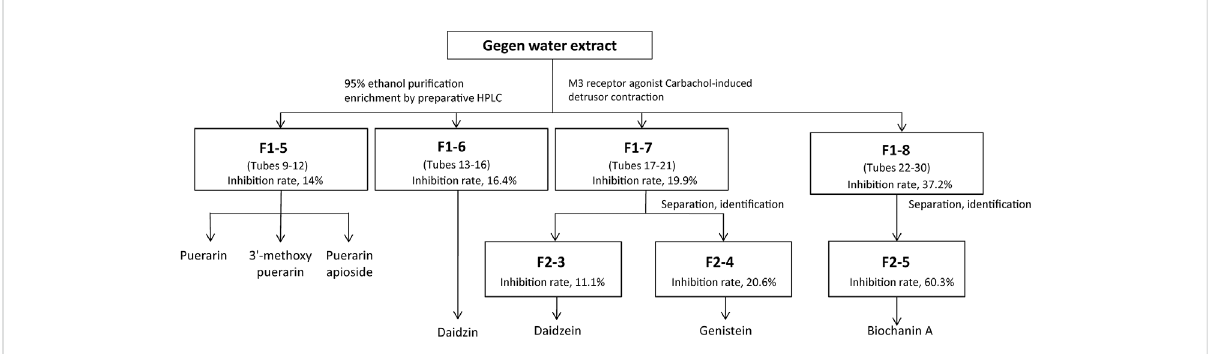
FIGURE 2 SchematicdiagramindicatesthefastisolationofactivefractionsfromGegenwaterextractusingbioassay-guidedfractionationwithpreparative HPLC. Active fractions were selected for further fractionation.